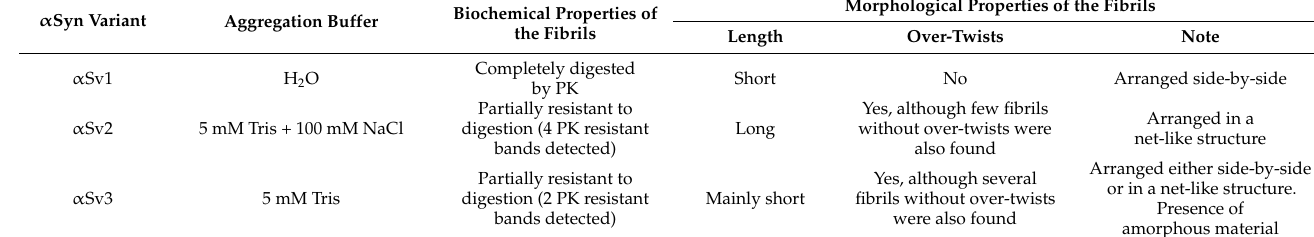
Table 1. Summary of the characteristics of recombinant α -synuclein variants.